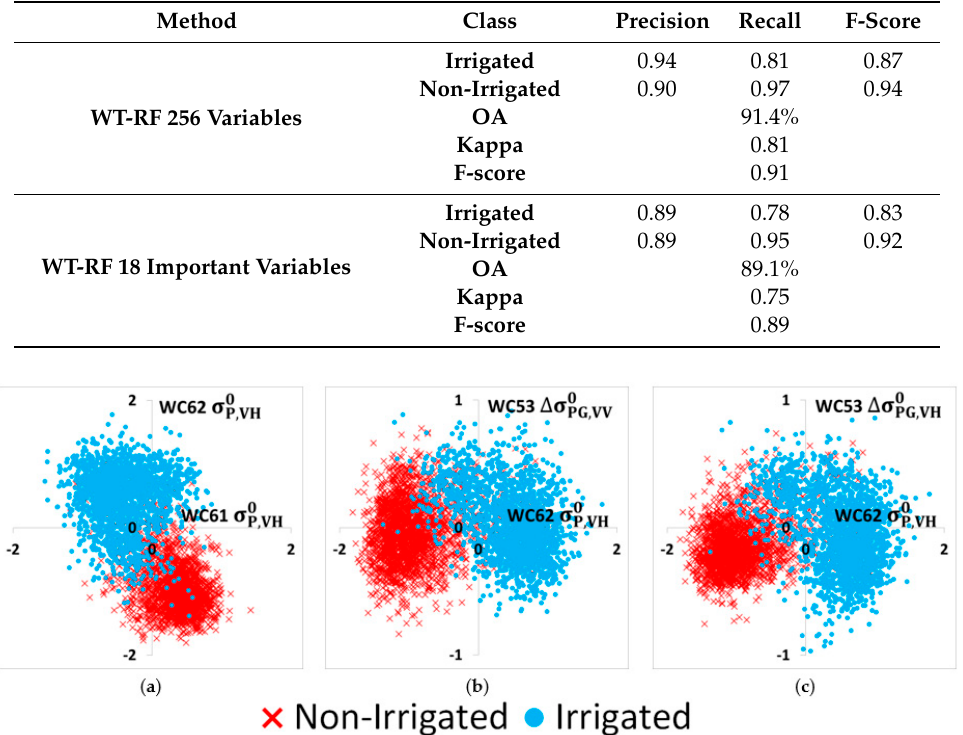
Table 4. The values of the overall accuracy, Kappa, F-score, precision, and recall obtained from the RF